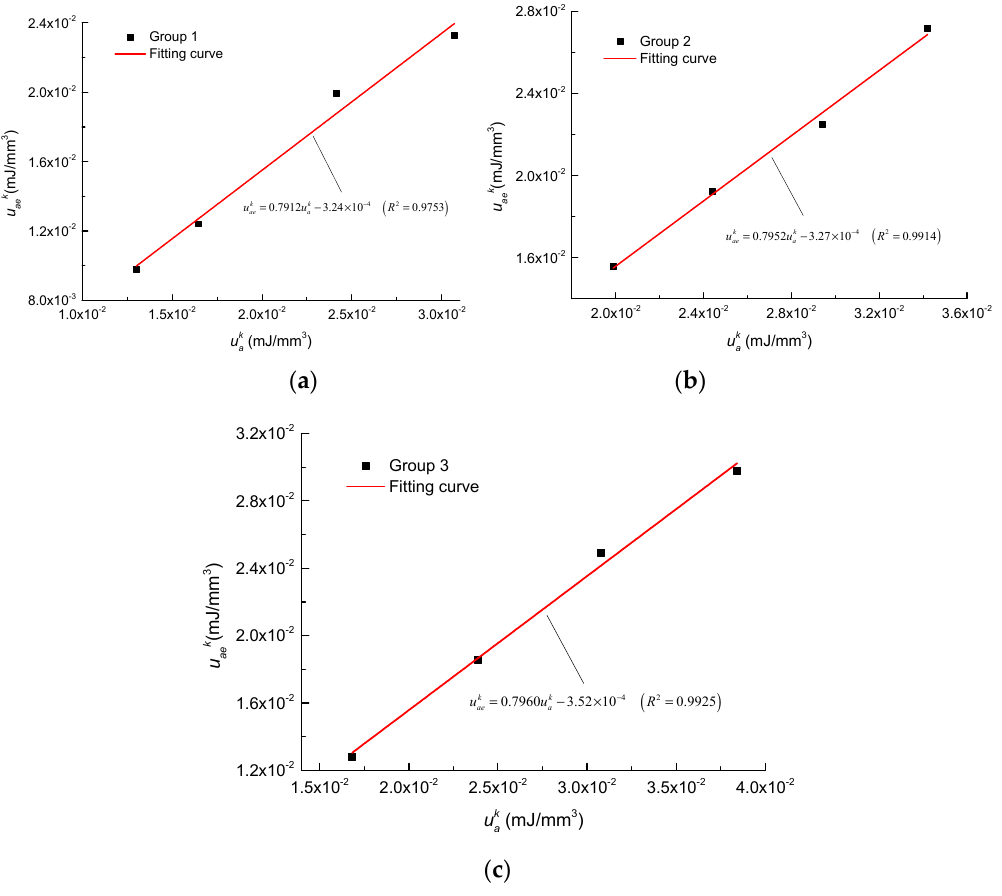
Figure 7. Relationship between elastic strain energy density and total input strain energy density for PJ coal mine: ( a ) Group 1; ( b ) Group 2; ( c ) Group 3. Table 3. Fitting parameters of A and B for three groups of